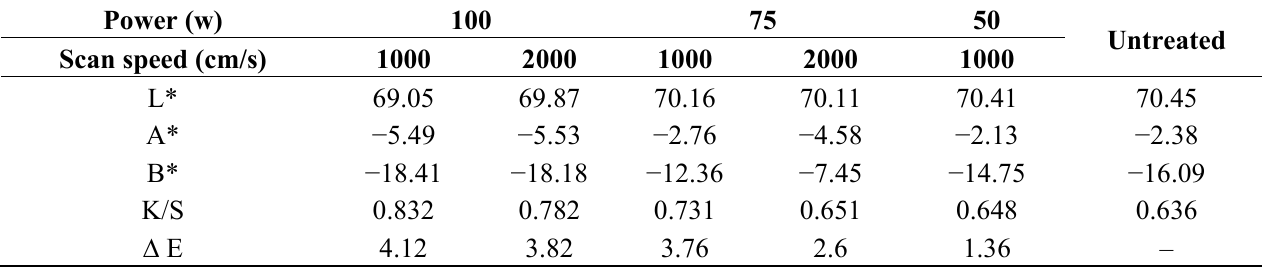
Table 1. Color parameters of methylene blue dyed untreated and laser treated cotton fabric. Power (w)